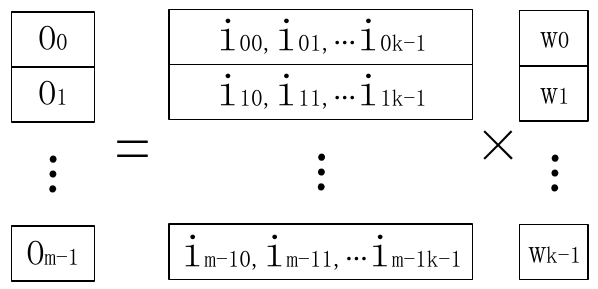
Figure 6. The method of calculating matrix multiplication by row.